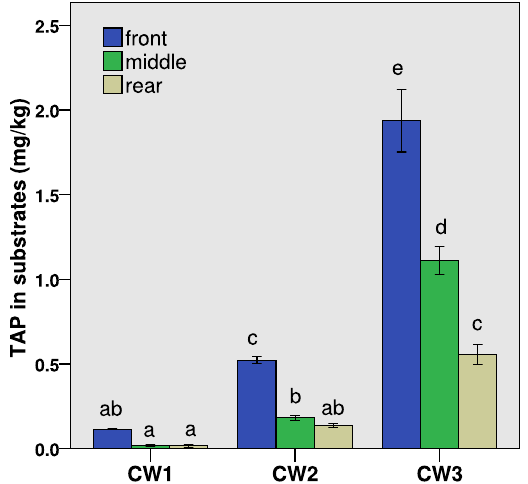
Figure 4. TAP content in the substrates from different regions (the front, middle and rear regions along the direction of flow) of the horizontal flow constructed wetlands (HSCWs) fed with mean influent TAP concentrations of 0.12 ± 0.04 mg L − 1 (CW1), 0.79 ± 0.29 mg L − 1 (CW2) and 3.96 ± 1.17 mg L − 1 (CW3) at the hydraulic loading of 100 mm d − 1 . Different letters indicate significant differences among the columns (P < 0.05).